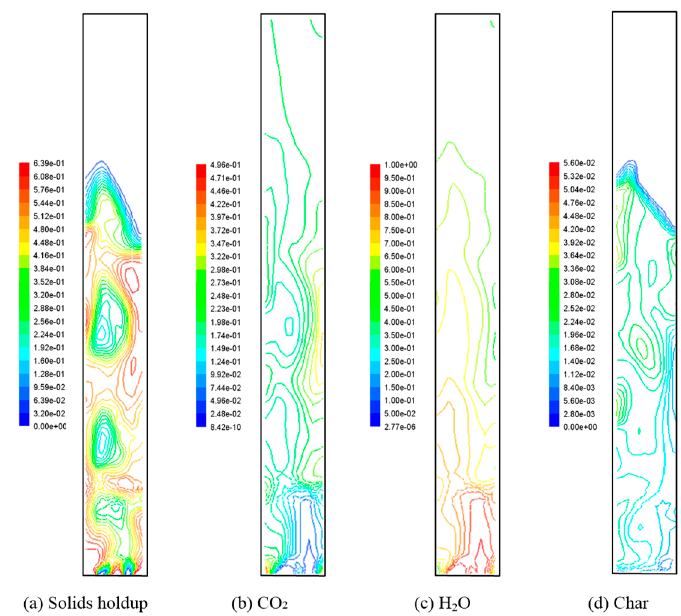
Figure 3. Axial (x = 0) distributions of flow patterns and gas–solid concentrations. ( a ) Solids holdup; ( b ) CO 2 molar fraction in gas phase; ( c ) H 2 O molar fraction in gas phase; ( d ) Char mass fraction in solid phase.